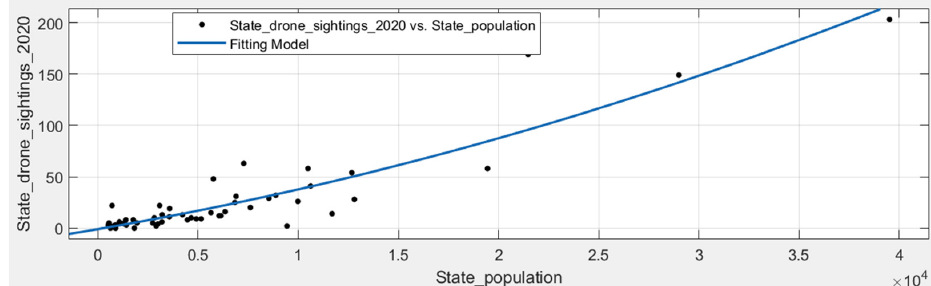
Figure 2. Correlation-fitting model between the population and the number of drone sightings for by State FAA airports in